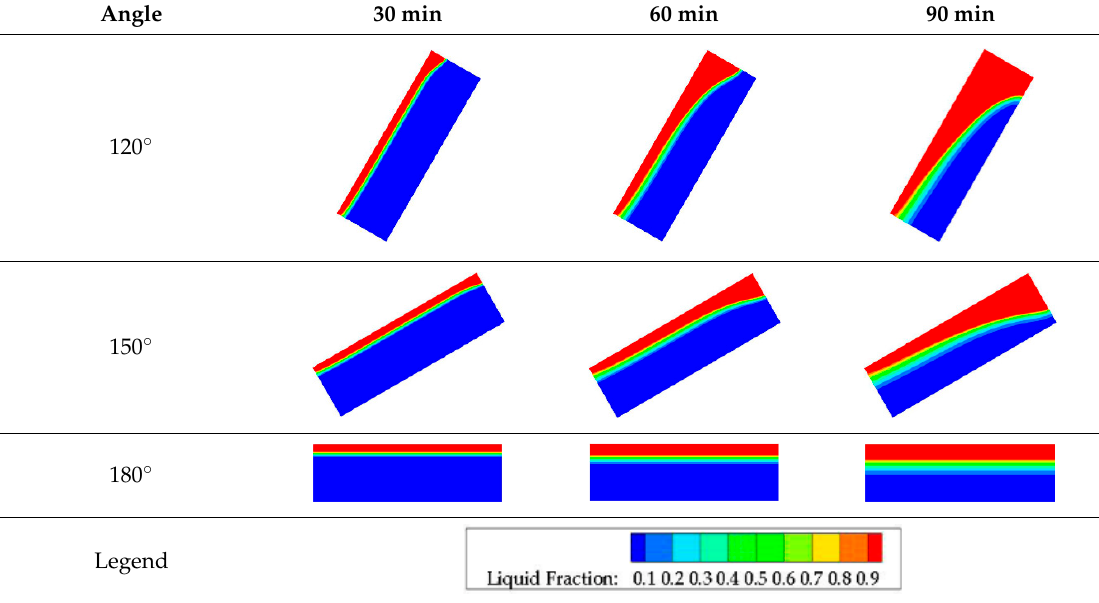
Figure 8. Comparison results for the case with 90° inclination angle between the numerical results (1– 5) and the experimental data ((1)–(5)).